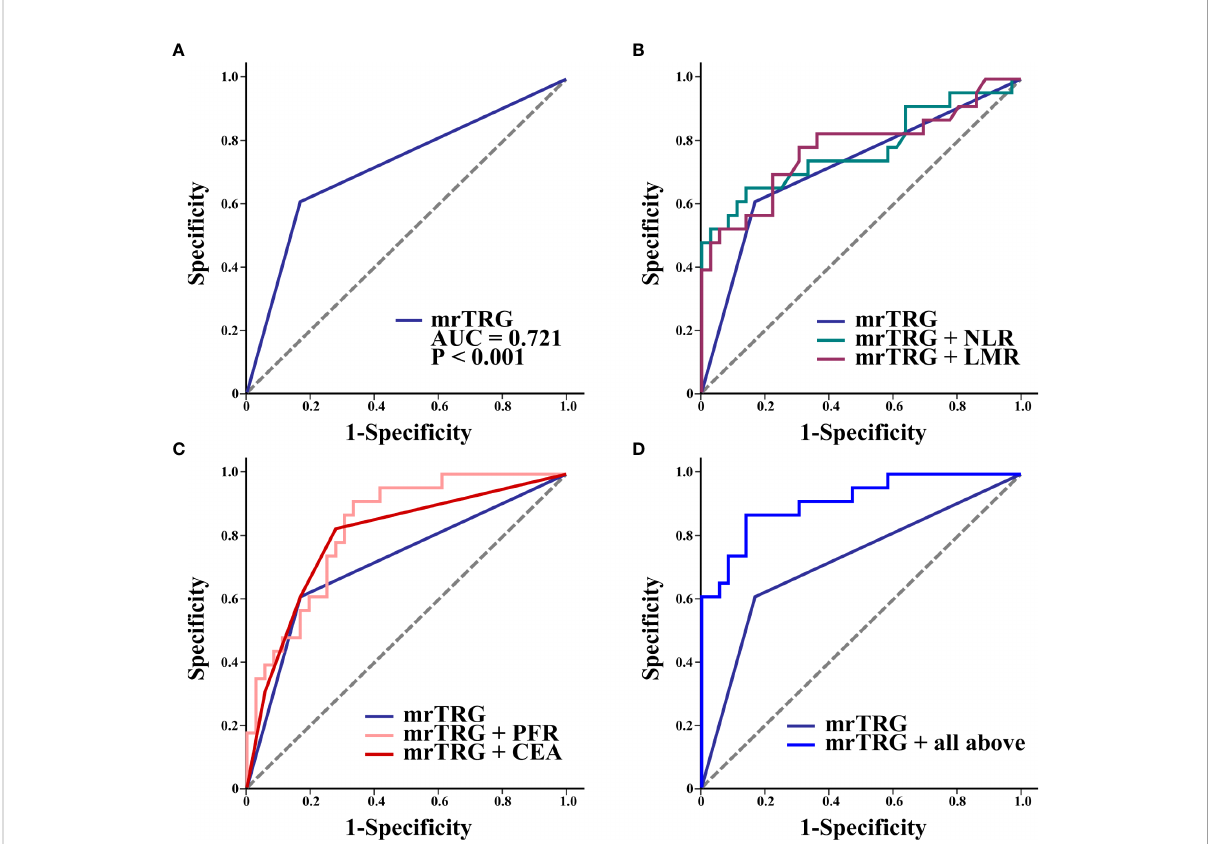
FIGURE 2 ROC curves of mrTRG (1-2 vs. 3-5) alone (A) and mrTRG plus pretreatment biomarkers (NLR, LMR, PFR, CEA and all above four biomarkers) (B – D) for the prediction of pCR.